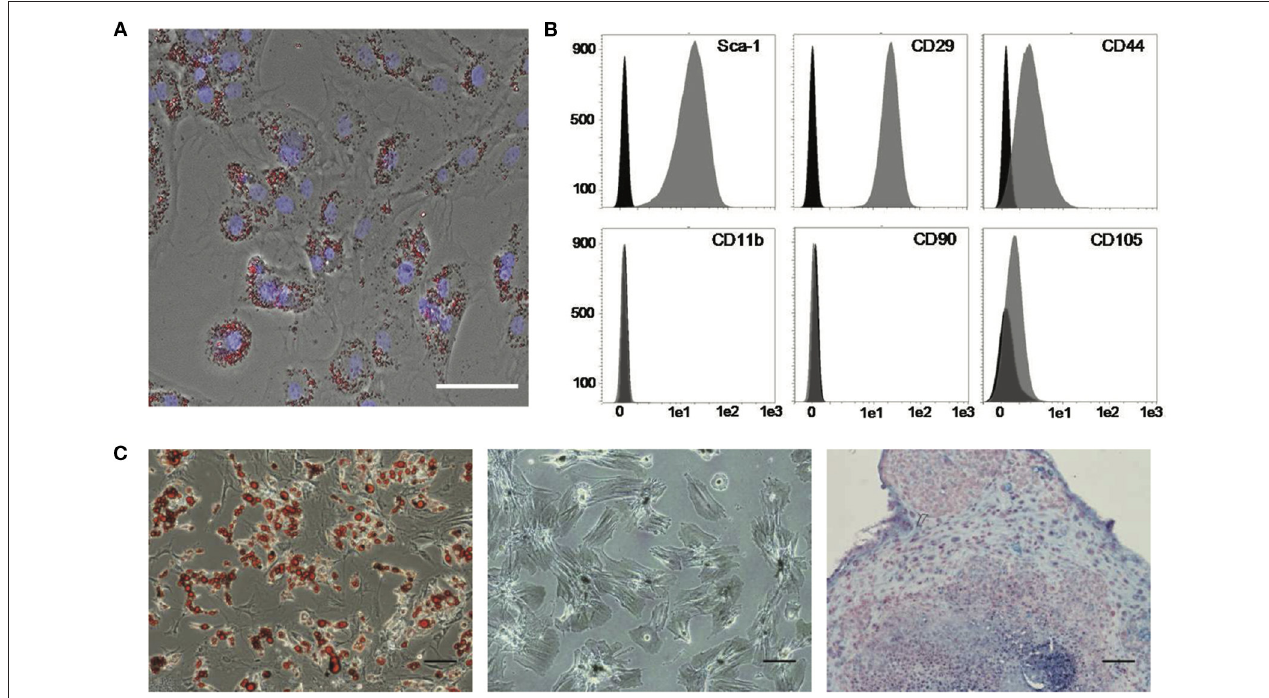
FIGURE 2 | Labeling and characterization of MSC. (A) Labeling of MSC with paramagnetic and fluorescent microspheres (red). Nuclei were counterstained with DAPI (blue). Scale bar: 50 µ m. (B) Flow cytometric analysis of MSC. Representative histograms for indicated surface markers used for validation of MSC identity are shown in gray. Black histograms show control measurements with isotype-matched unspecific antibodies. (C) Multi-lineage differentiation potential of MSC into adipogenic, osteogenic, and chondrogenic derivatives (from left). Cells were stained for lipid vesicles (red, left panel), intracellular calcium deposits (black, middle panel), and hyaluronic acid in extracellular matrix (blue, right panel), indicative of respective cell types. Scale bars: 100 µ m. MSC, mesenchymal stromal